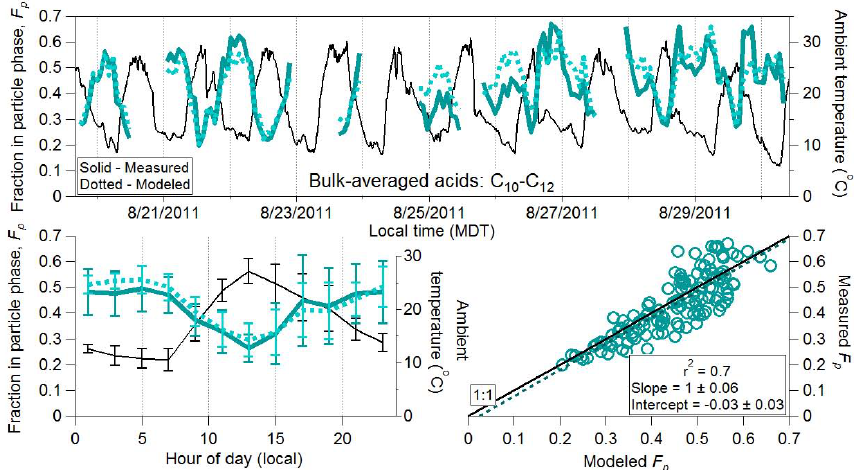
Fig. 8. Time series, diurnal cycle, and scatter plot of measured and modeled F p for C 10 –C 12 averaged bulk acids. Model uses excess oxygen as a hydroxyl